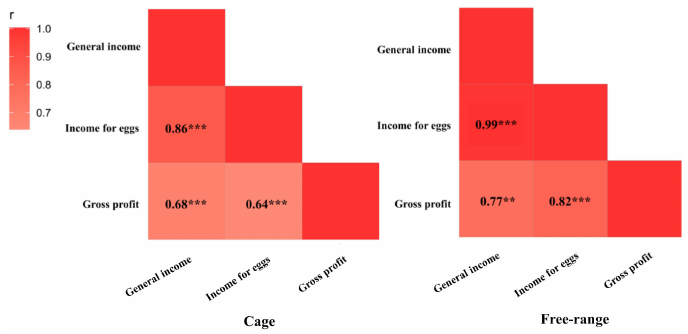
Figure 6. Spearman correlations between general income, income for eggs and gross profit. Note: Significant differences are denoted by ** p < 0.01, and *** p < 0.001.